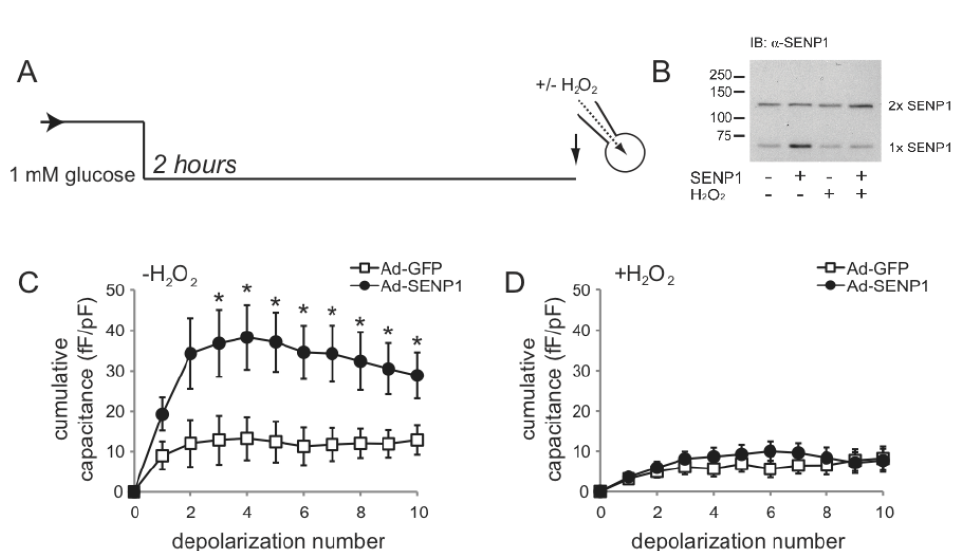
Figure 5. SENP1 amplification of  -cells is redox-dependent. ( A ) Mouse  -cells, infected with adenovirus expressing GFP (Ad-GFP) or SENP1 (Ad-SENP1, which co-expresses GFP), were maintained in non-stimulatory glucose (1 mM) for 2 hours prior to whole-cell patch-clamp. In some experiments, H O (200 µM) was infused directly into cells at the 2 2 time of the experiment; ( B ) Immunoblotting of protein lysates from INS-1 832/13 cells demonstrates the up-regulation of monomeric SENP1 (with Ad-SENP1) and its subsequent dimerization in the presence of H O (200 µM); ( C , D ) Over-expression of SENP1 2 2 recapitulates the effect of NADPH to amplify β-cell exocytosis ( C ), an effect that is lost under oxidizing conditions ( D ). * p < 0.05 compared with